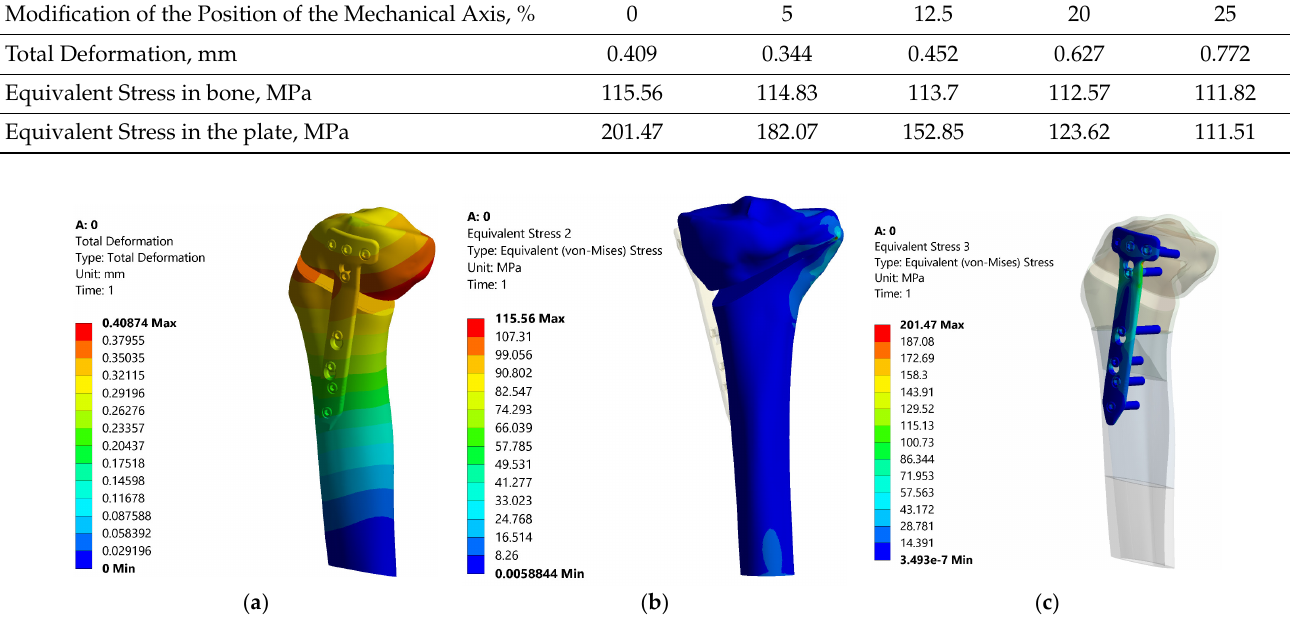
Figure 13. Distributions of the total deformation, equivalent stress in tibia and equivalent stress in the plate—0%.